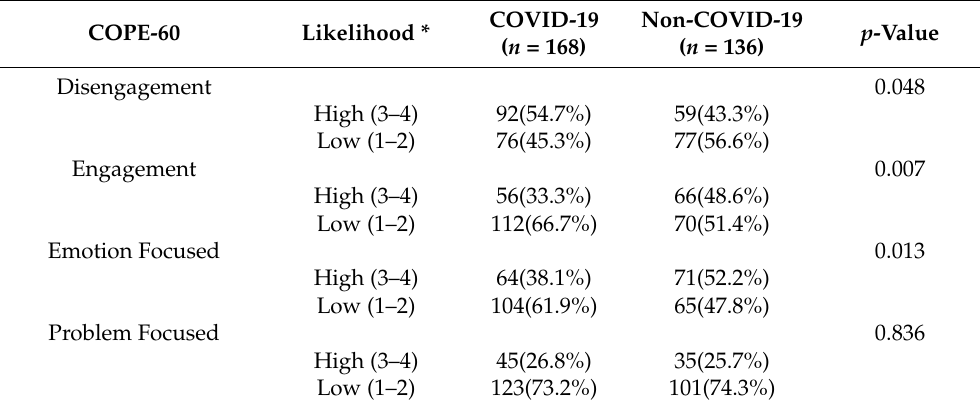
Table 2. COPE-60 questionnaire results between COVID-19 positive and negative pregnant women.